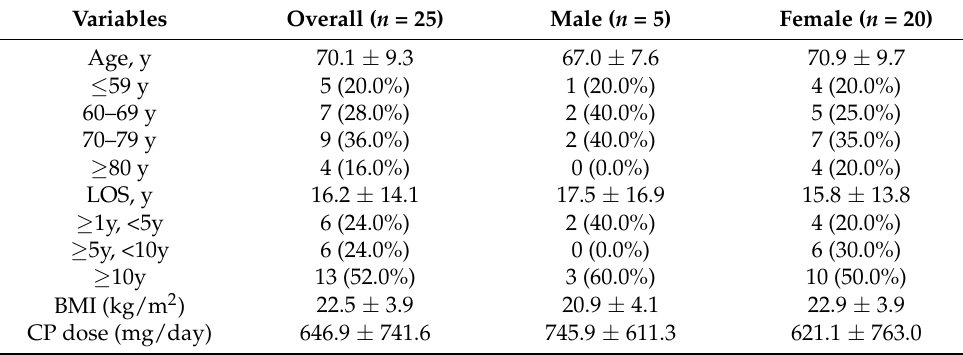
Table 1. Characteristics of the study participants.